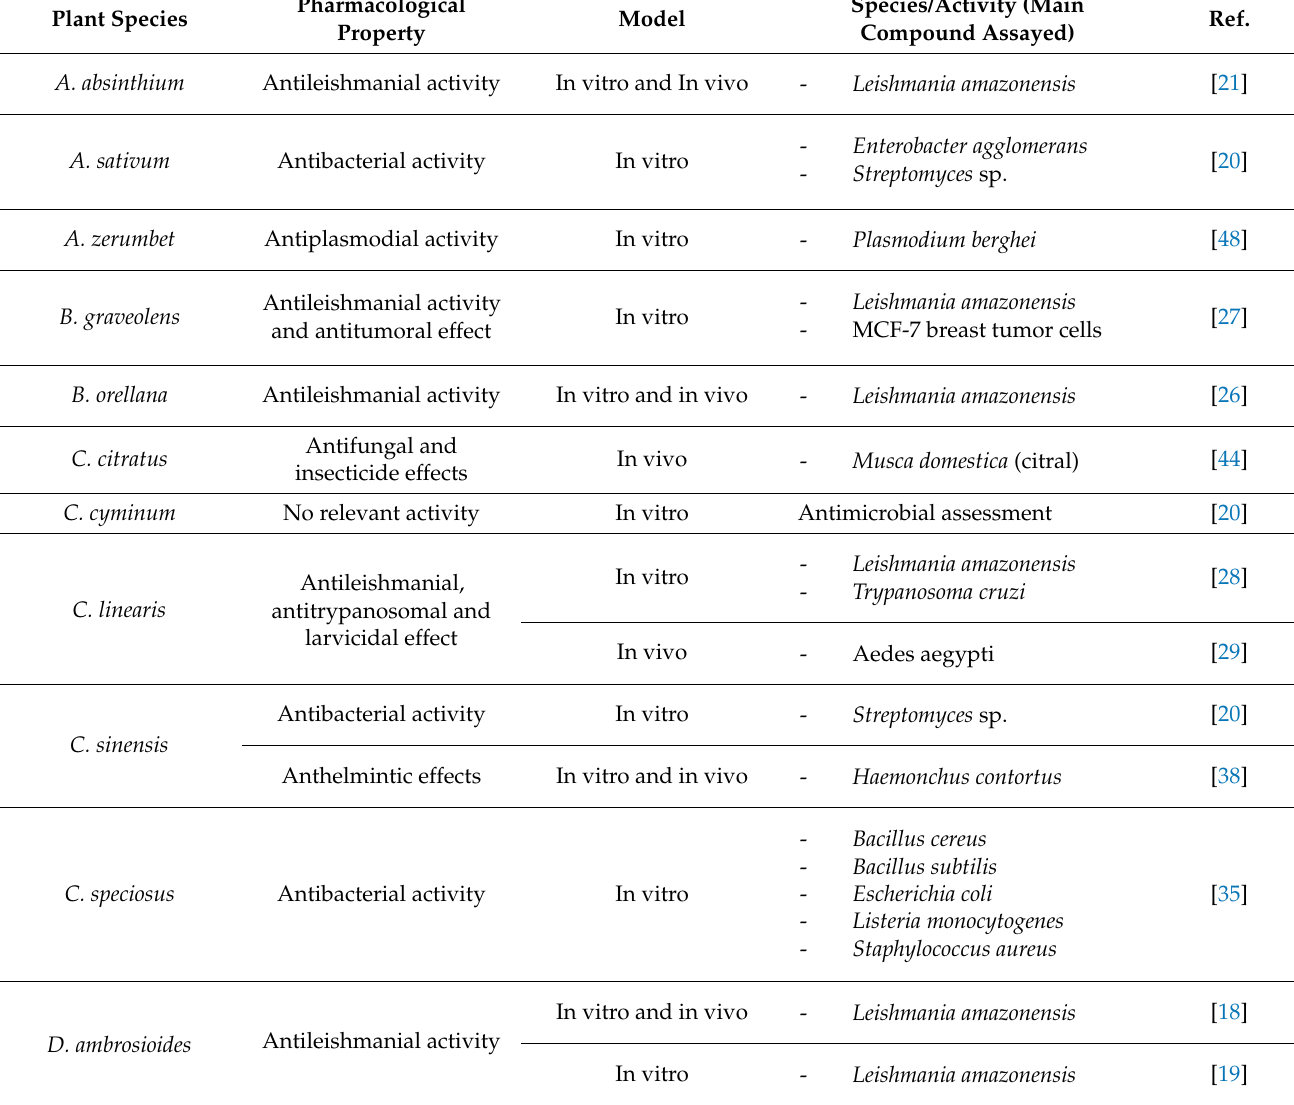
Table 3. Pharmacological studies of essential oils and main compounds from Cuban plants included in this review. Plant